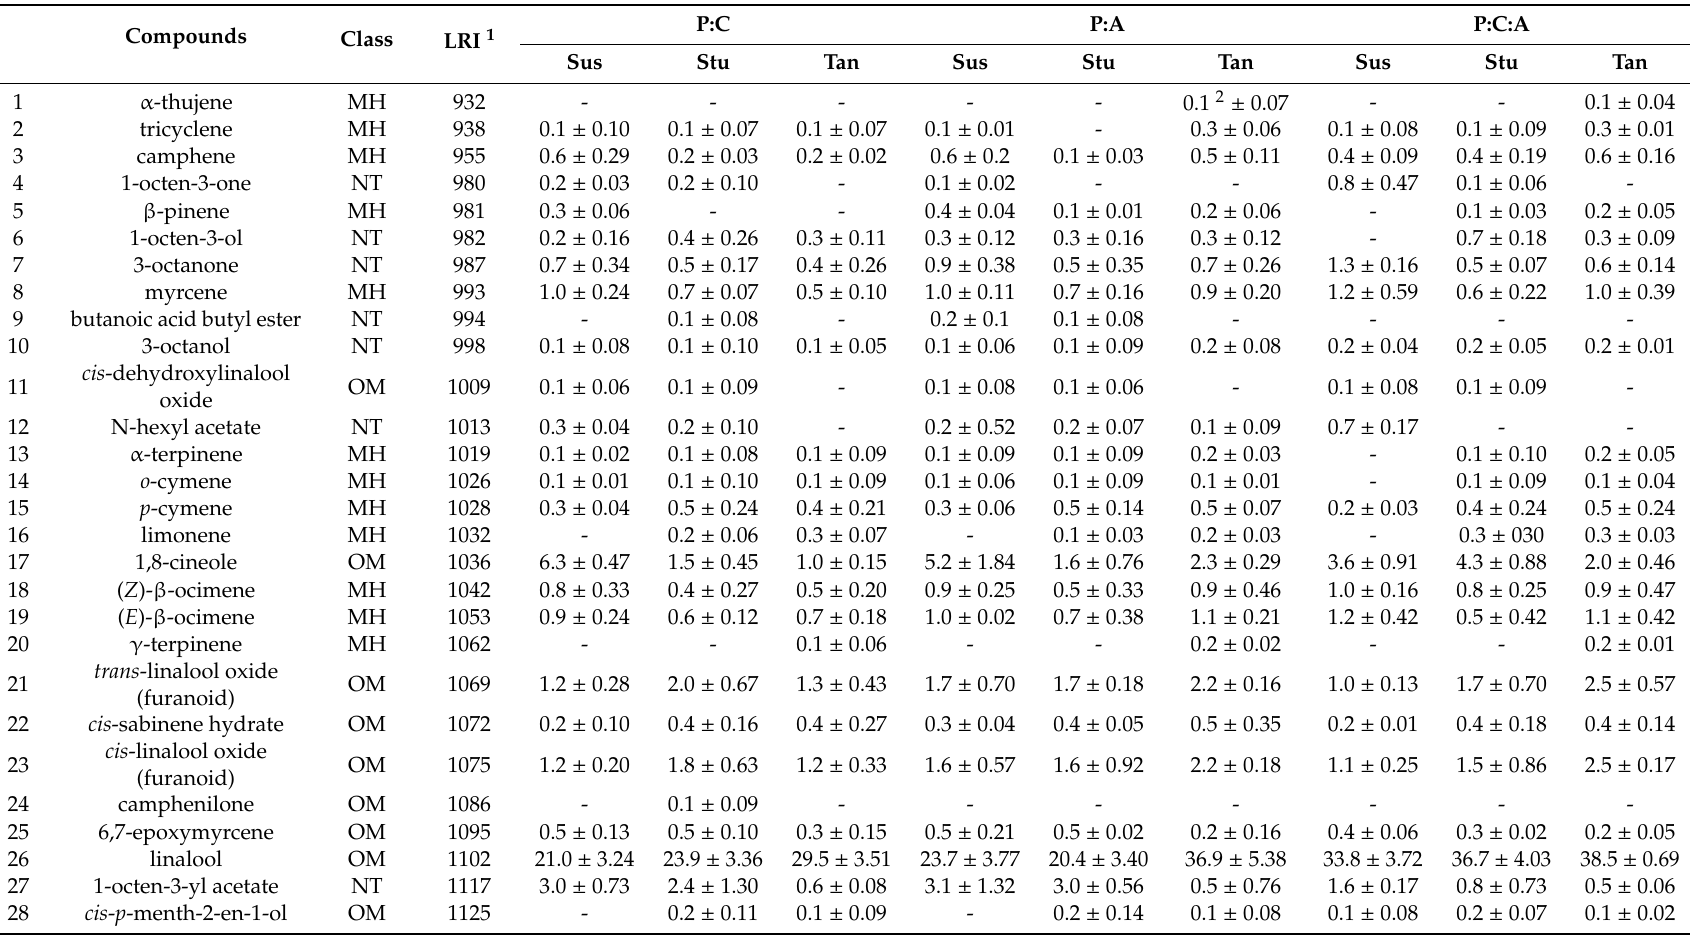
Table 5. Percentage of major constituents in lavender essential oils obtained from lavender selections collected in Susa (Sus), Stura (Stu), and Tanaro (Tan) valleys and grown in pot with di ff erent substrates (P:C = peat and green compost, 70%:30% v / v ; P:A = peat and demolition aggregates, 70%:30% v / v ; P:C:A = peat, green compost and demolition aggregates, 40%:30%:30% v / v ) with standard